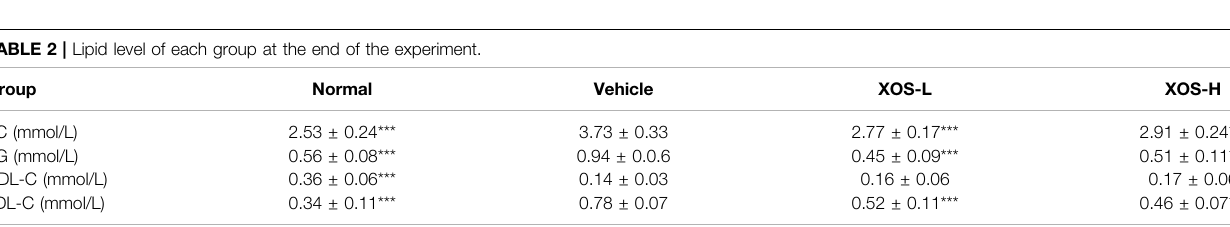
Frontiers in Pharmacology |